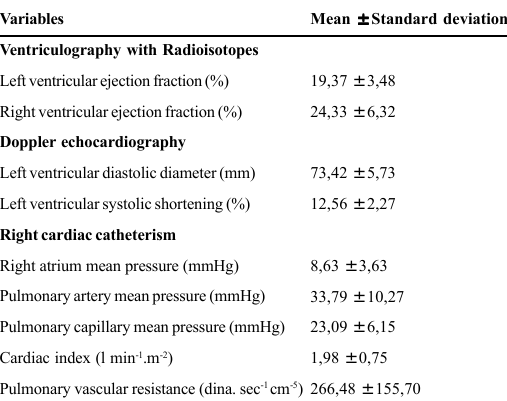
Table 1. Pre-operative laboratorial